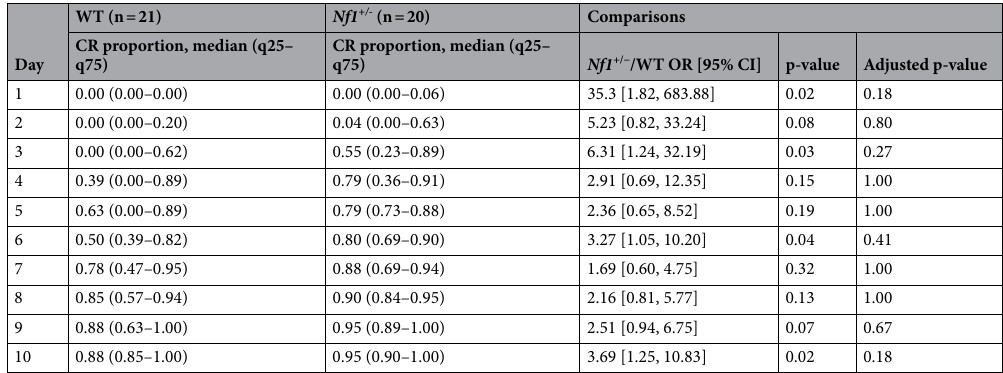
Table 2. CR proportion in the 250 ISI training phase. An odds ratio (OR) > 1 indicates a higher CR proportion in the Nf1 +/− mice over the wild type (WT) mice.